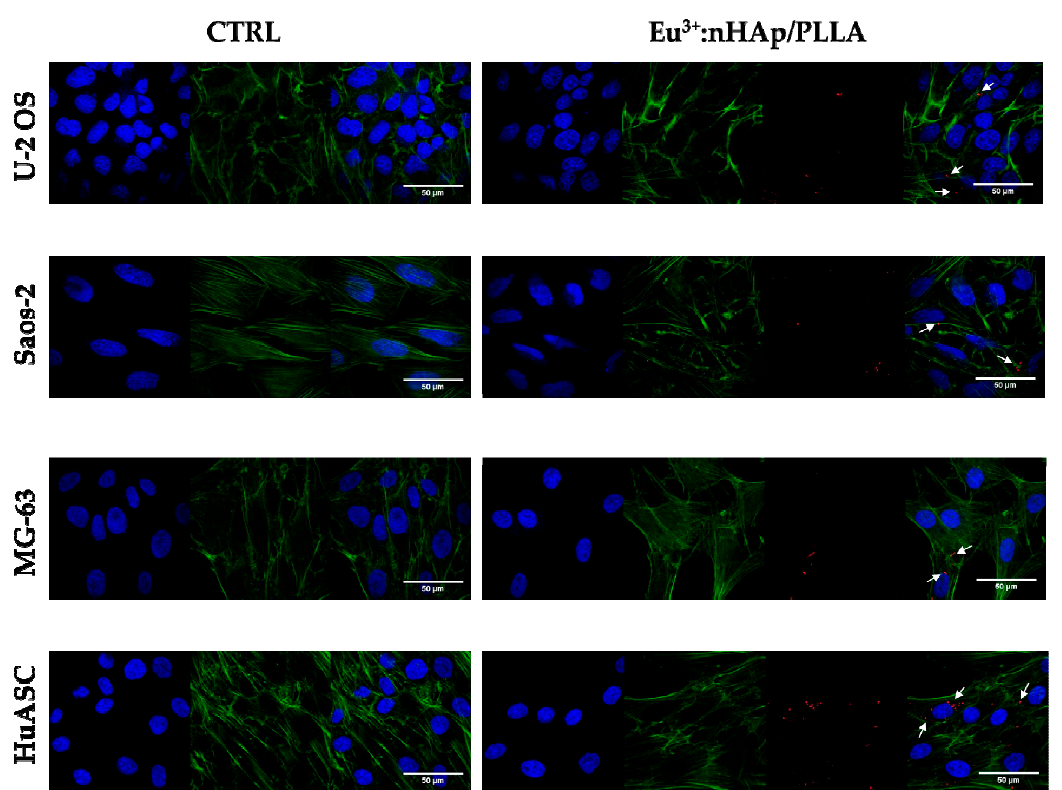
Figure 1. The comparison of cells morphology in control conditions (i.e., on polystyrene / CTRL) and on biomaterial (10 wt % 3 mol % Eu 3 + : nanohydroxyapatite (nHAp) / poly(L-lactic acid) PLLA. The morphology of cells was visualized using confocal microscope. Cells were stained with DAPI (blue, nuclei) and phalloidin atto-488 (green, actin cytoskeleton). Additionally, in research groups the Eu 3 + ions were visualized (red dots – marked by white cursors). Magnification: 630 × , scale bar: 50 µ m indicated on merged figure.